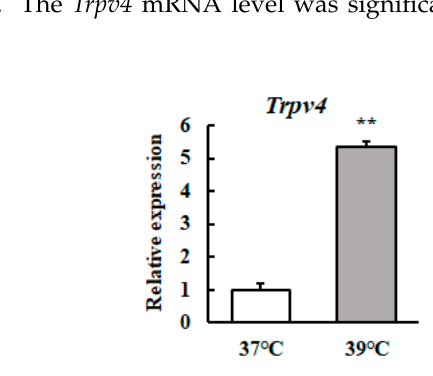
Figure 2. Heat treatment at 39 ◦ C increases the Trpv4 mRNA level in HC11 cells. HC11 cells were maintained at 37 ◦ C or exposed to 39 ◦ C for 72 h. The Trpv4 mRNA level was detected by RT-qPCR. GAPDH was used as the reference gene. The results are expressed as the mean values ± standard error of the mean from four independent experiments. ** p < 0.01 compared to the control.